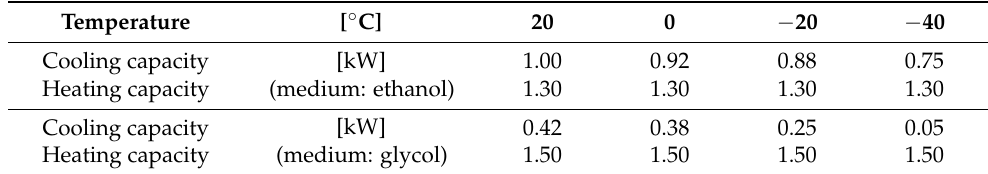
Table 1. Performance values of cooling/heating section.